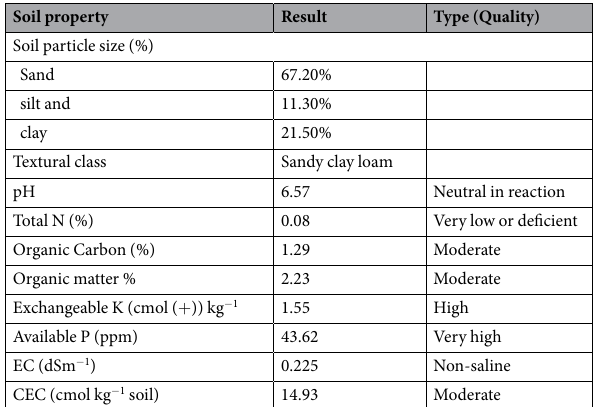
Table 1. Soil Physico-chemical properties of the experimental site before planting. Source: Mekelle Soil laboratory of Tigray Regional Soil Laboratory.